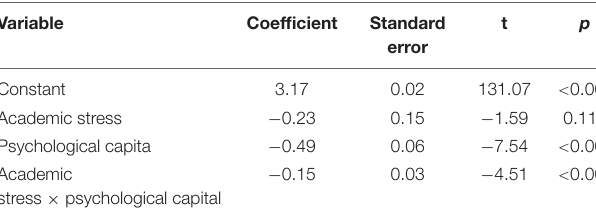
TABLE 12 | Test results of the moderating effect of psychological capital on academic stress, and